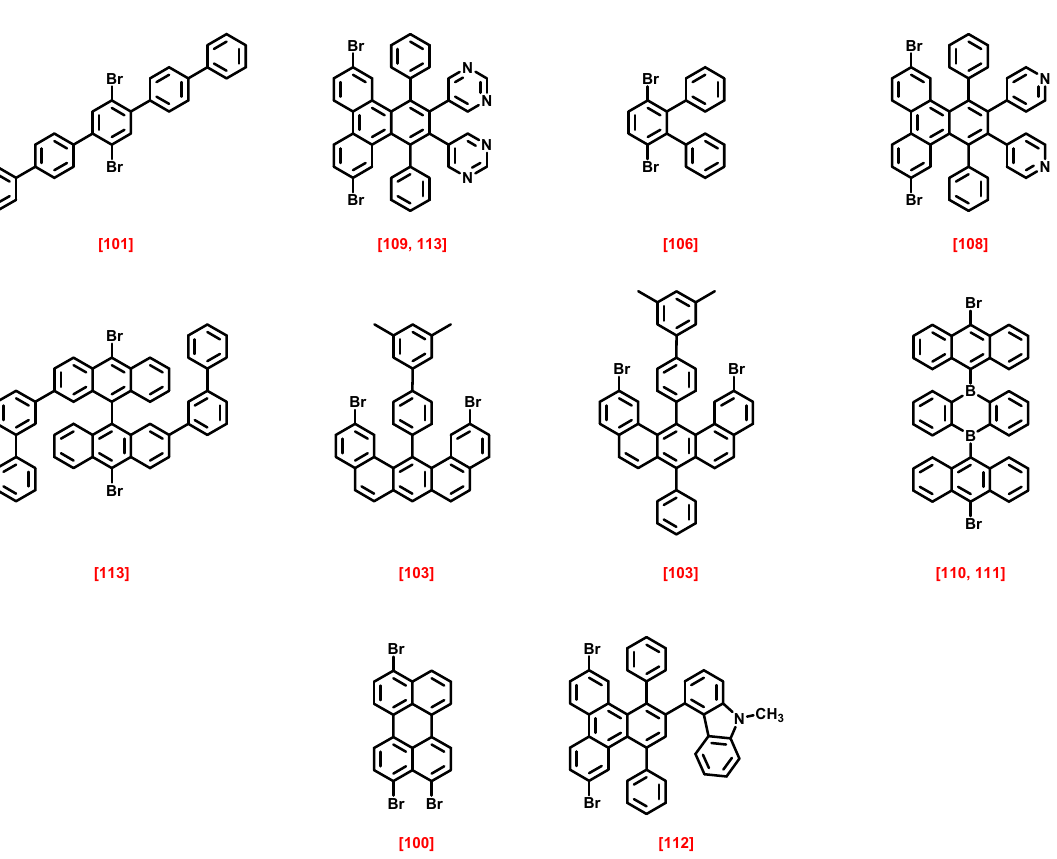
Figure 19. Chemical structures of precursors used to elaborate graphene nanoribbons (GNRs) and the corresponding reference in brackets.